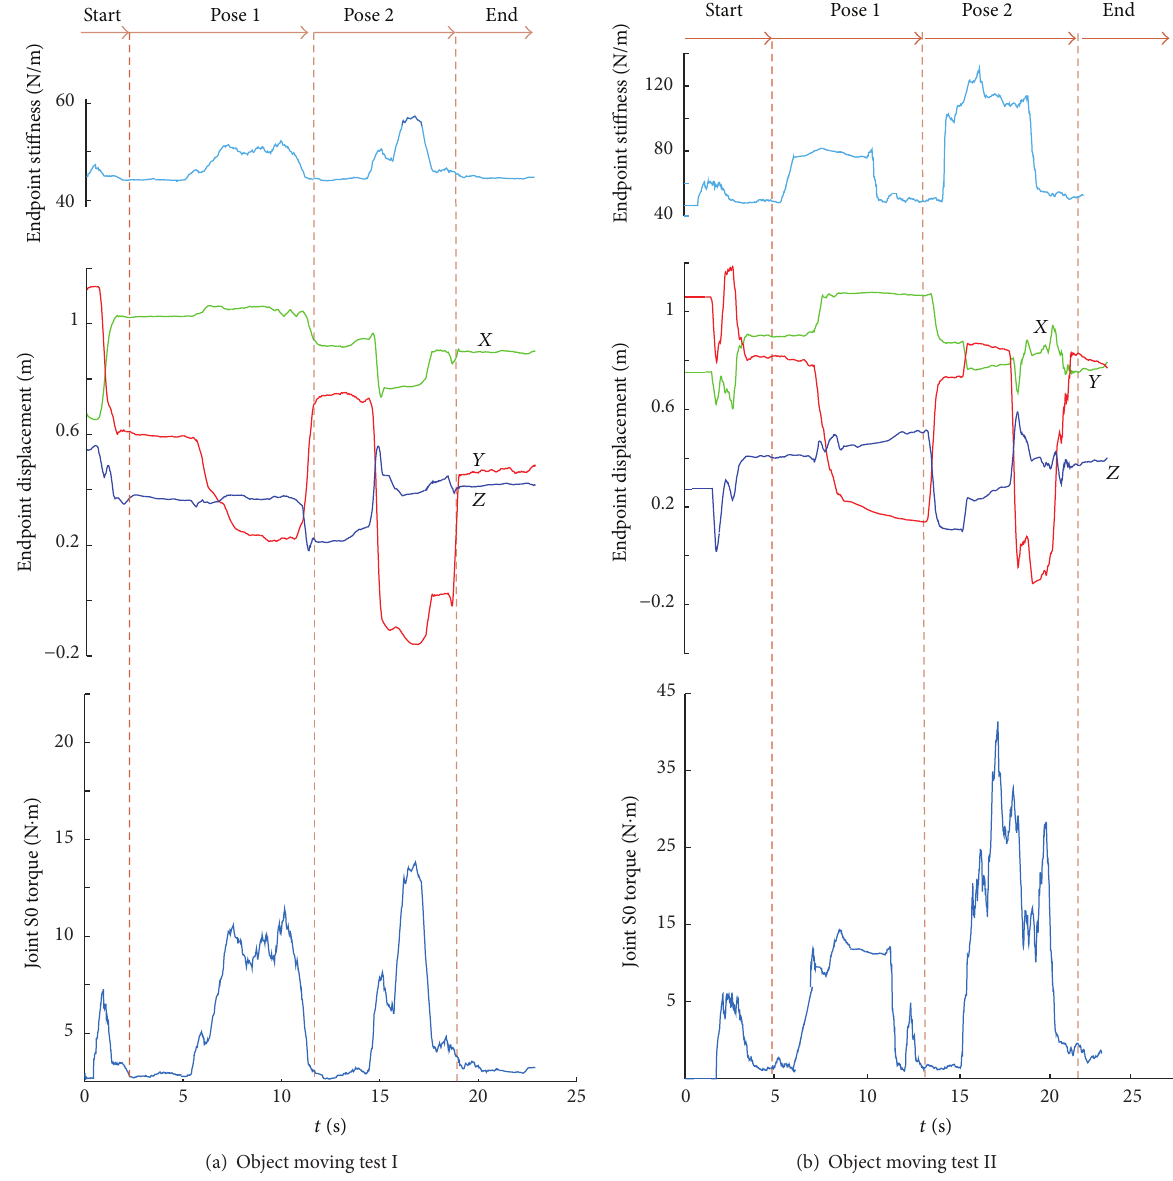
Figure 13: Object moving test results: (a) object moving without human postural stiffness index transfer; (b) object moving with human postural stiffness transfer. Both the two tests are composed of four steps: start to move Baxter robot endpoint to the target; move objects using pose 1; and move objects with pose 2 and finally finish moving objects. The predominated Baxter robot joint S0 is selected to track the torque variations during the